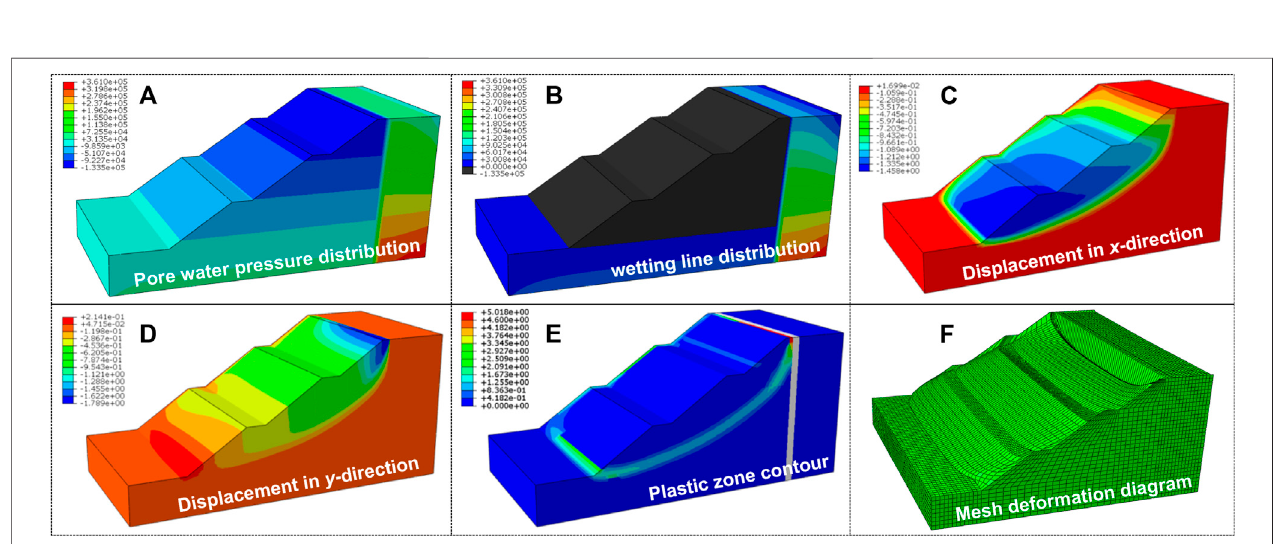
FIGURE 3 | (A) Pore water pressure distribution; (B) wetting line distribution; (C) displacement in x -direction; (D) displacement in y -direction; (E) plastic zone contour; and (F) mesh deformation diagram of the slope with the water-stop curtain.